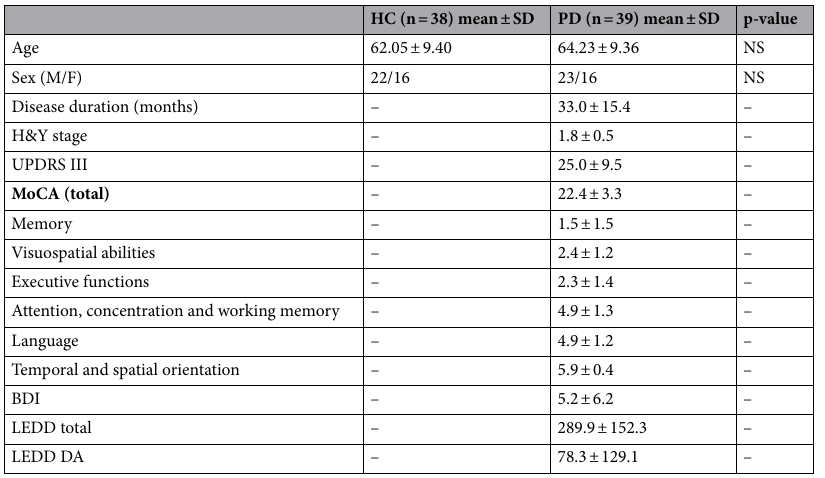
Table 1. Demographic and clinical features of PD patients. Data are given as mean ± standard deviation (SD). NS not significant, PD Parkinson’s disease, HC healthy controls, H&Y Hoehn & Yahr, UPDRS Unified Parkinson’s Disease Rating Scale, MoCA Montreal Cognitive Assessment, BDI Beck depression inventory, LEDD Levodopa Equivalent Daily Dose, DA